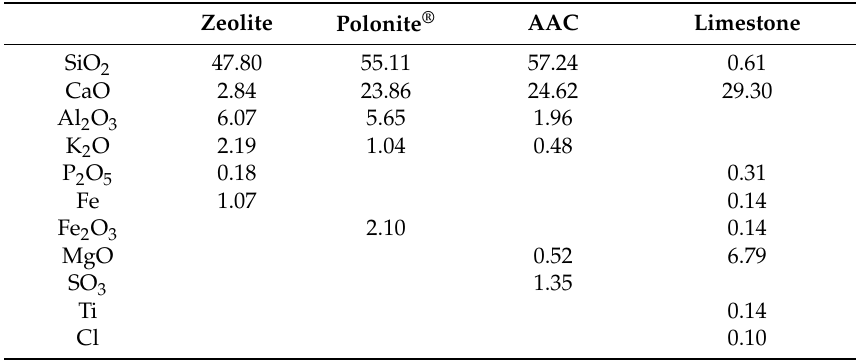
Table 2. Main mineral compounds of tested reactive materials